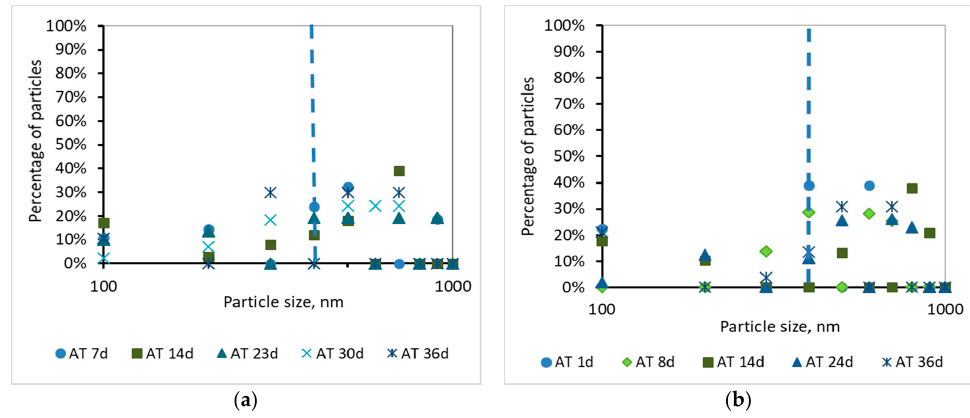
Figure 8. Percentage of particles smaller than 1000 nm for a sample from the aeration tank (AT) as a function of MBR operation time ( a ) for synthetic versus ( b ) domestic wastewater.